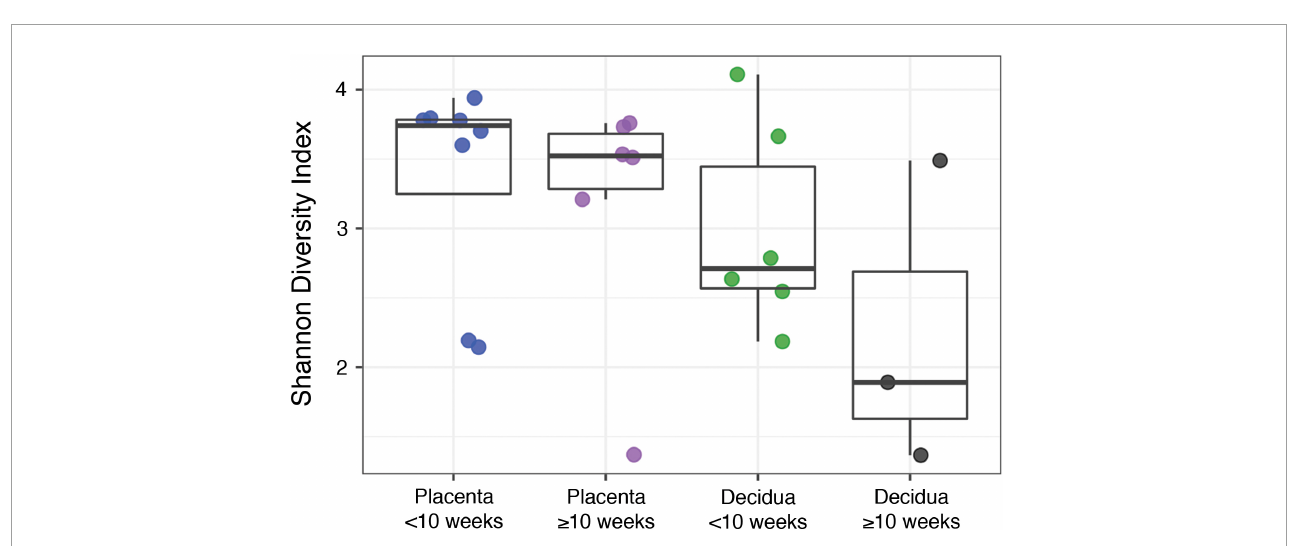
FIGURE2 Alpha diversity between placental and decidual samples before and after 10 weeks gestational